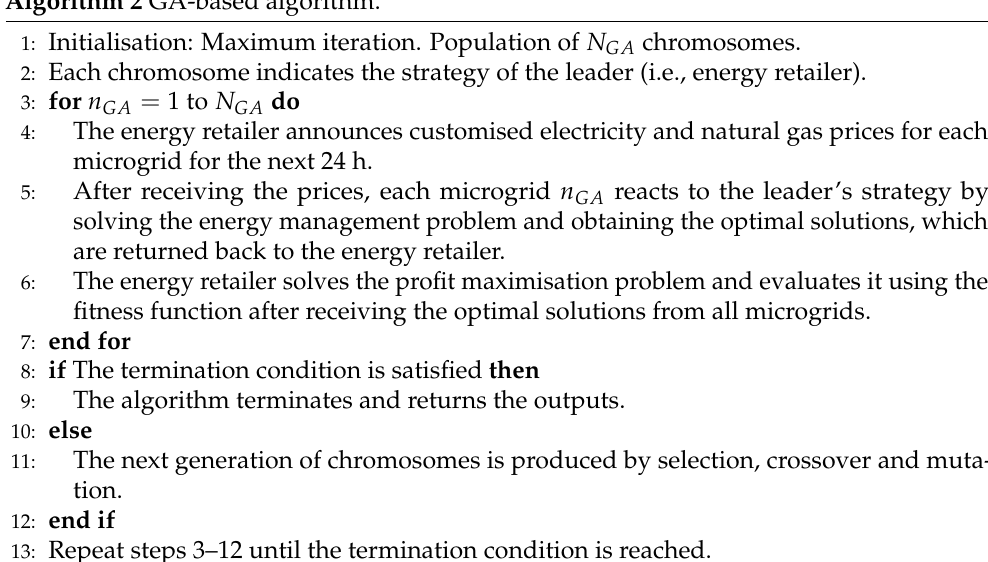
Algorithm 2 GA-based